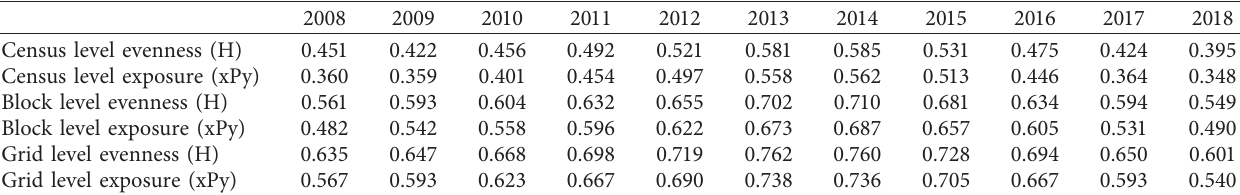
Figure 5: Kernel density distribution of housing price of different periods in Hangzhou. (a) 2008. (b) 2010. (c) 2012. (d) 2014. (e) 2016. (f) 2018. Table 2: Residential heterogeneity of different periods and scales in Hangzhou.